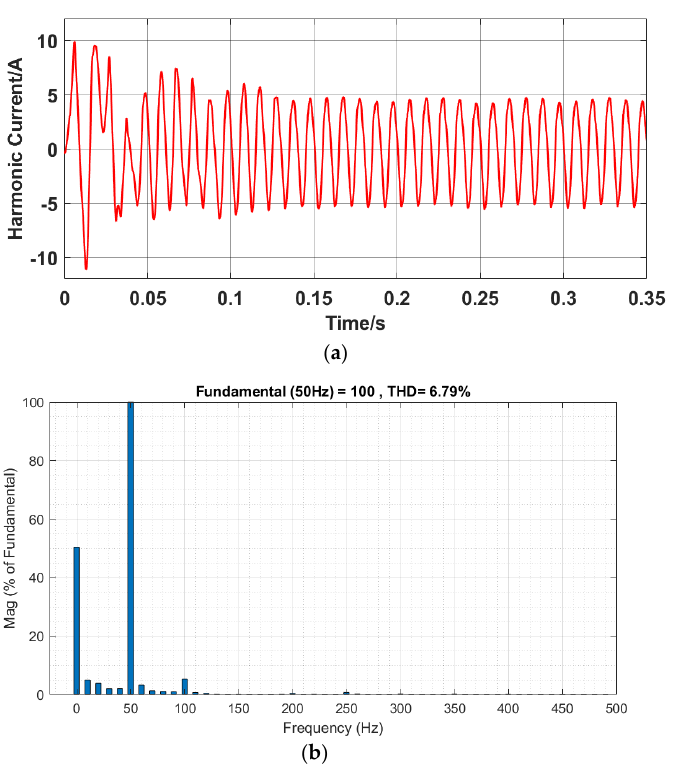
Figure 11. ( a ) Harmonic current without the suppressor. ( b ) FFT analysis of the bridge arm current without the suppressor. The case of using the PI control circulating current suppressor is shown in Figure 12. The harmonic current component waveform is shown in Figure 12a, and the THD of the arm current was 5.23%, as shown in Figure 12b.